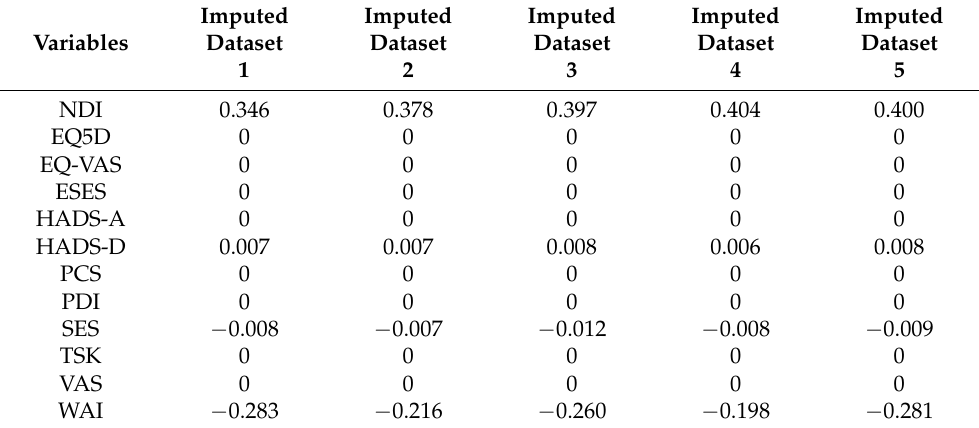
Table 2. Selected predictor variables for response variable of NDI at 1